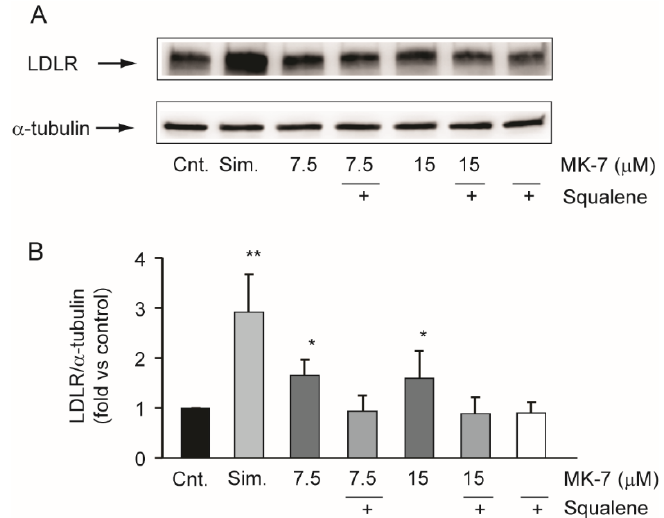
Figure 4. Effect of squalene on MK-7-dependent induction of LDLR. A and B ) Human hepatoma cells incubated for 24 h with simvastatin (5 µ M) and MK-7 in the presence or absence of squalene (10 µ M). LDLR protein expression was evaluated by Western blot analysis. α -tubulin was used as the loading control. ( B ) Densitometric readings were evaluated using ImageLab TM software. Di ff erences between treatments were assessed by Student’s t test. * p < 0.05 vs. control; ** p < 0.01; Sim.: simvastatin.